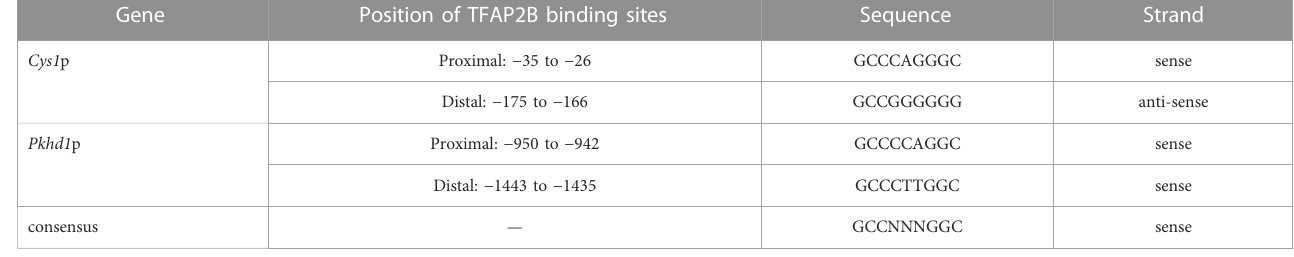
TABLE 1 Predicted TFAP2B binding sites in the Cys1 and Pkhd1 promoters.